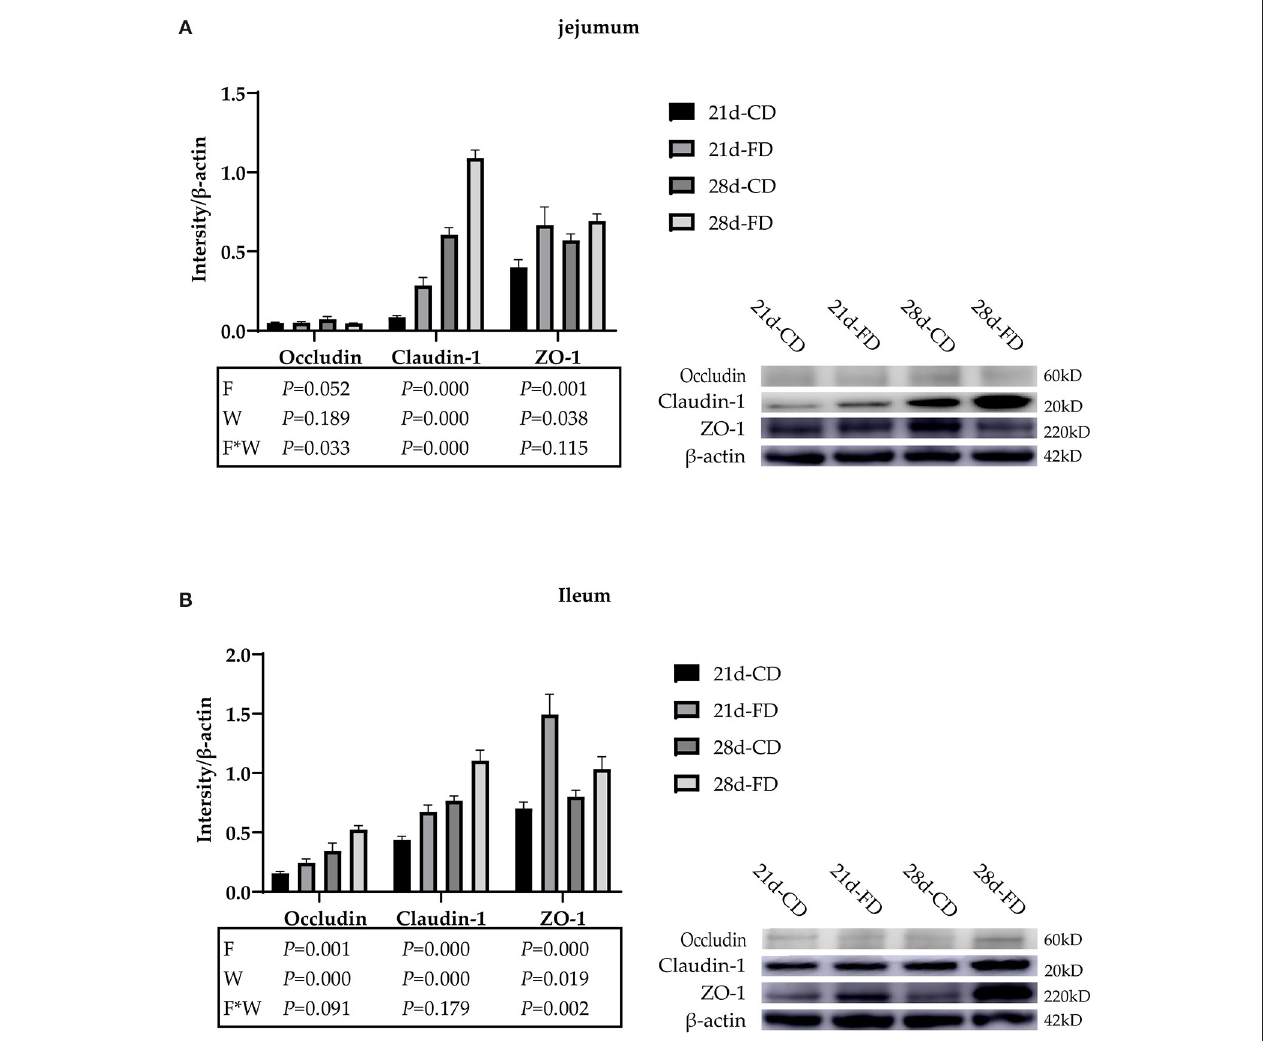
FIGURE 4 | The effects of fermented diet and weaning age on the tight junction proteins expression in the small intestine of weaned piglets. The protein expression of Occludin, Claudin, and ZO-1 in the jejunum (A) and ileum (B) were detected via western blotting, and the intensity of the bands was determined using Image J. 21d-CD, 21-day-old weaned piglets fed the control diet. 21d-FD, 21-day-old weaned piglets fed the fermented diet. 28d-CD, 28-day-old weaned piglets fed the control diet. 28d-FD, 28-day-old weaned piglet fed the fermented diet. F, the main effect of fermented diet. W, the main effect of weaning age. F*W, the interaction effect between fermented diet and weaning age. Values are presented as the mean ±